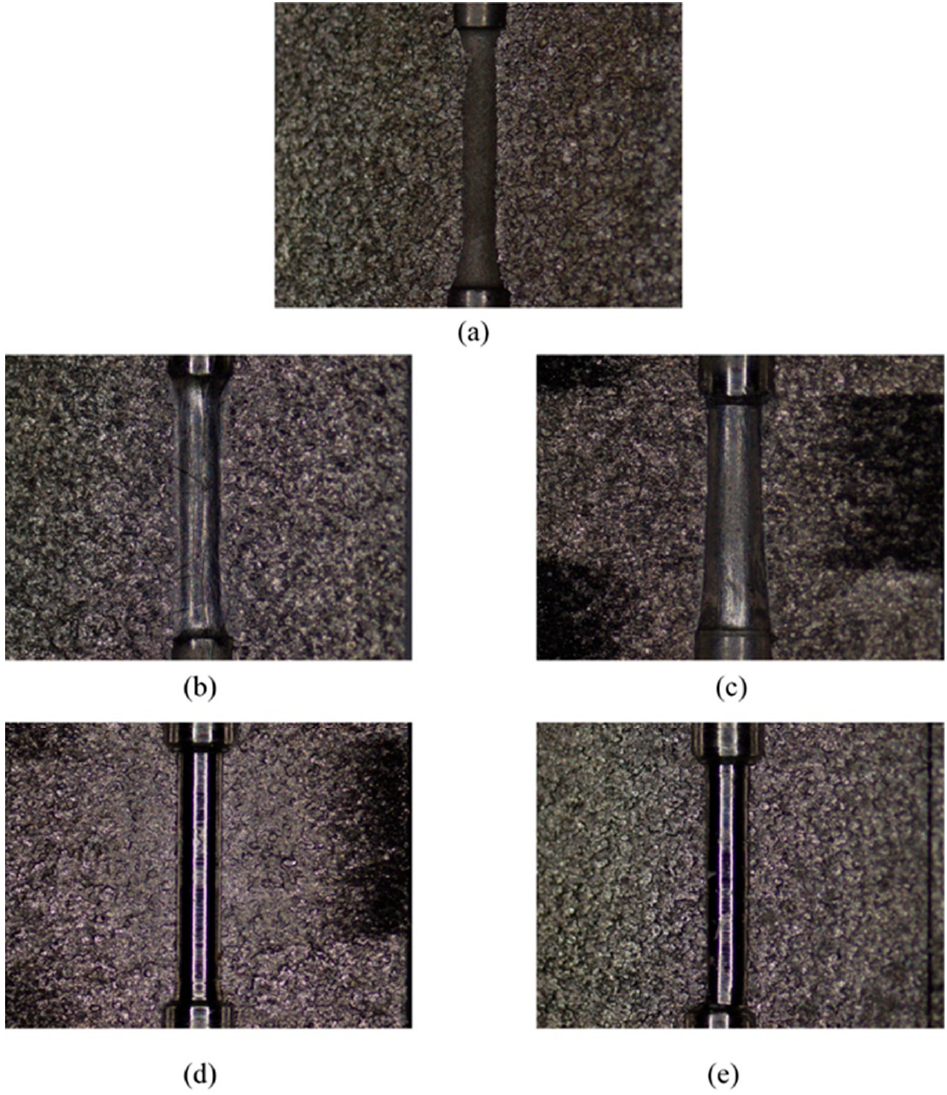
Figure 4. Stereoscopic microscopic of seven-order variable-diameter pipe workpieces. ( a ) Original #0; ( b ) Sample #1; ( c ) Sample #2; ( d ) Sample #3; ( e ) Sample #4.